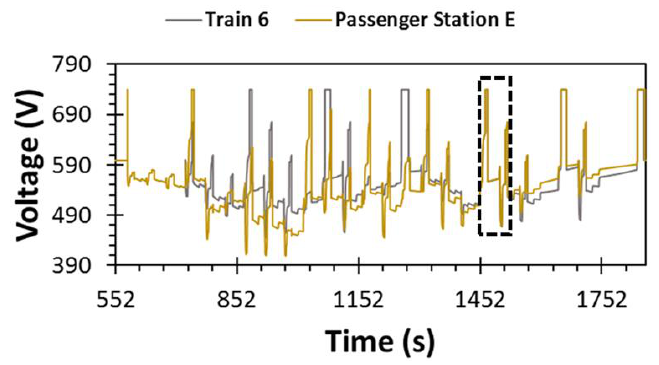
Figure 21. Train 1 voltage and passenger station F against time.